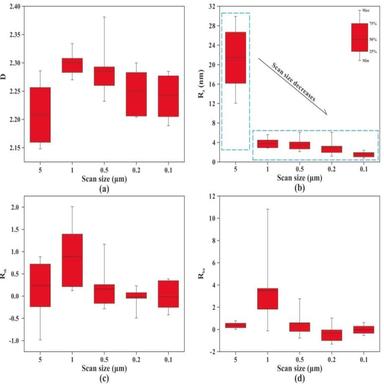
Variation of surface evaluation parameters for coal samples at different scan size.